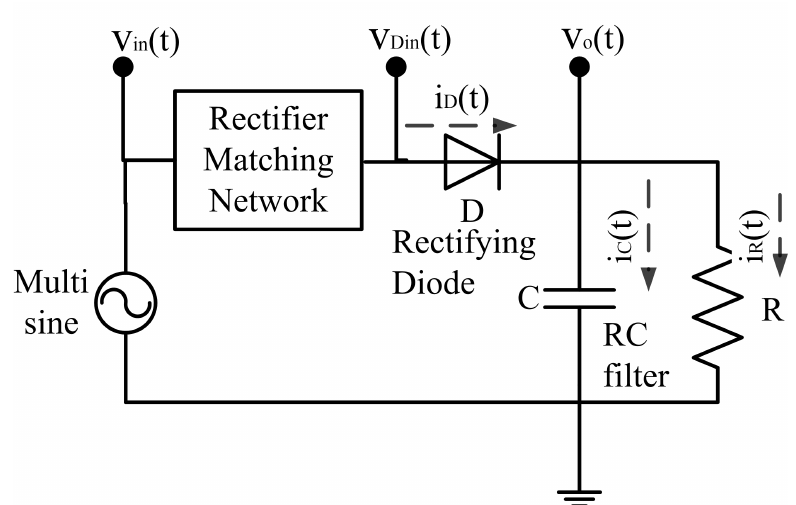
Figure 3. Basic rectifier